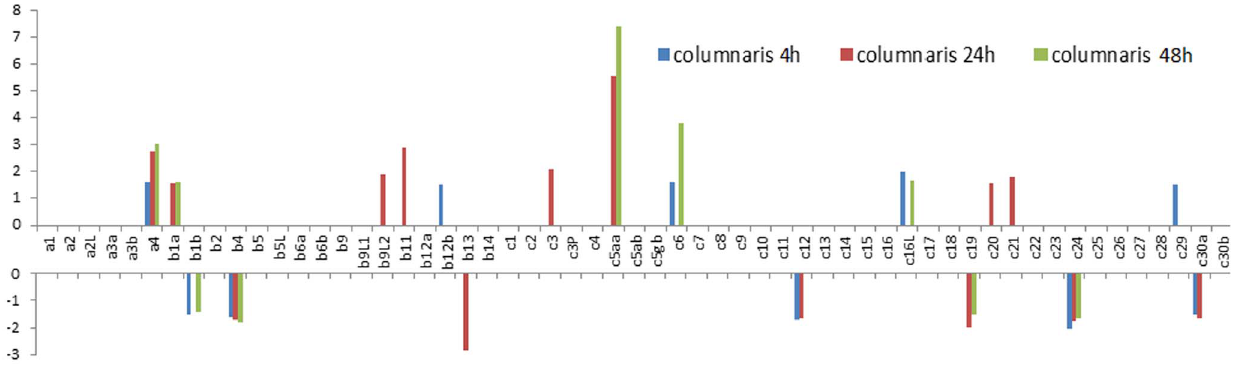
Fig. 5. Column bar chart showing the fold change of Hsp40s expression in F. Columnare challenge experiments. Vertical axis shows the value of fold change. Gene names are shown as clipped name without ‘‘dnaj’’. For instance, a1 means ‘‘ dnaja1 ’’. ‘‘c3P’’ represents ‘‘ dnajc3_prkri